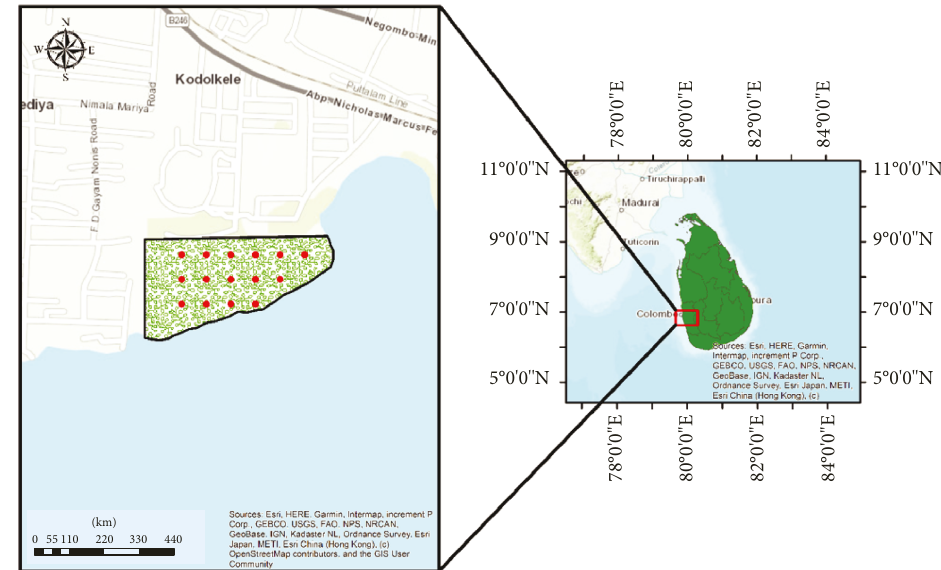
Figure 1: The geographic location of the study area with the sample plots (Red